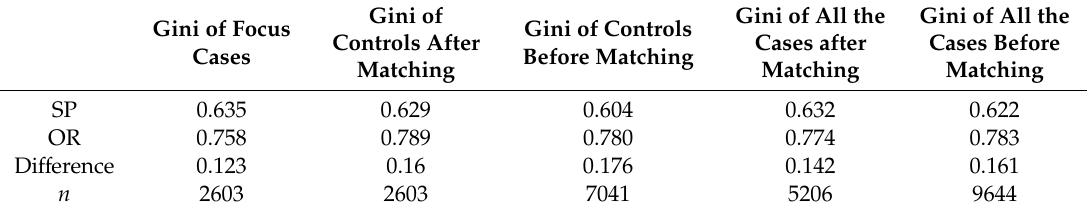
Table 4. Statistics (Gini Coe ffi cients) of the Empirical Experimental Data.